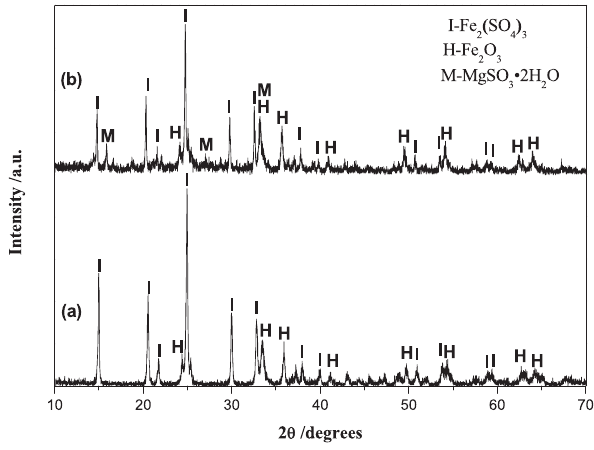
Fig. 5: XRD profiles of the products calcined at 750°C, (a) conventional calcinations and (b) microwave